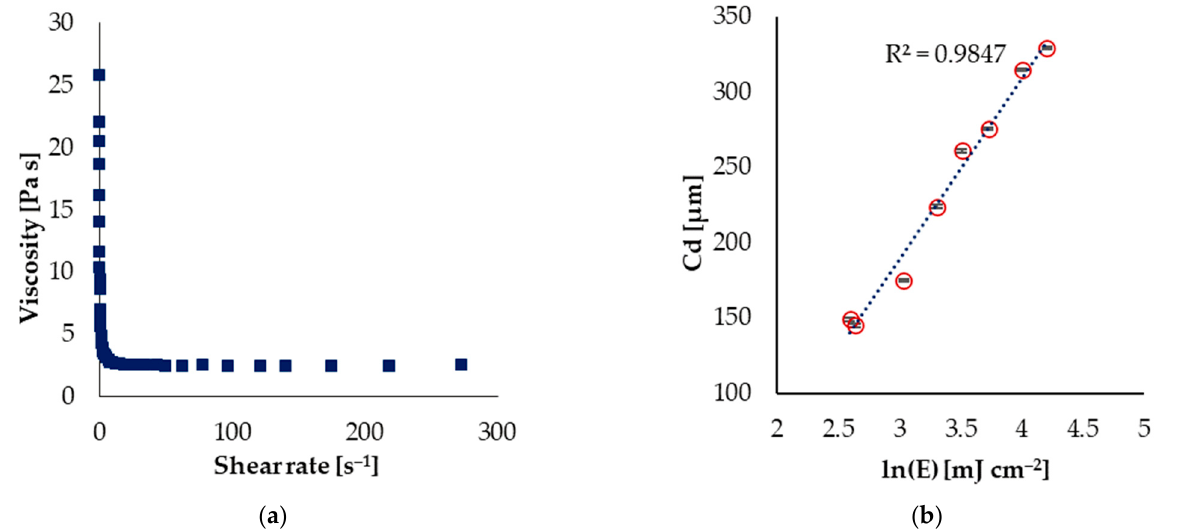
Figure 5. ( a ) Measured viscosity of the ceramic slurry. ( b ) Cure depth vs. energy density [34].